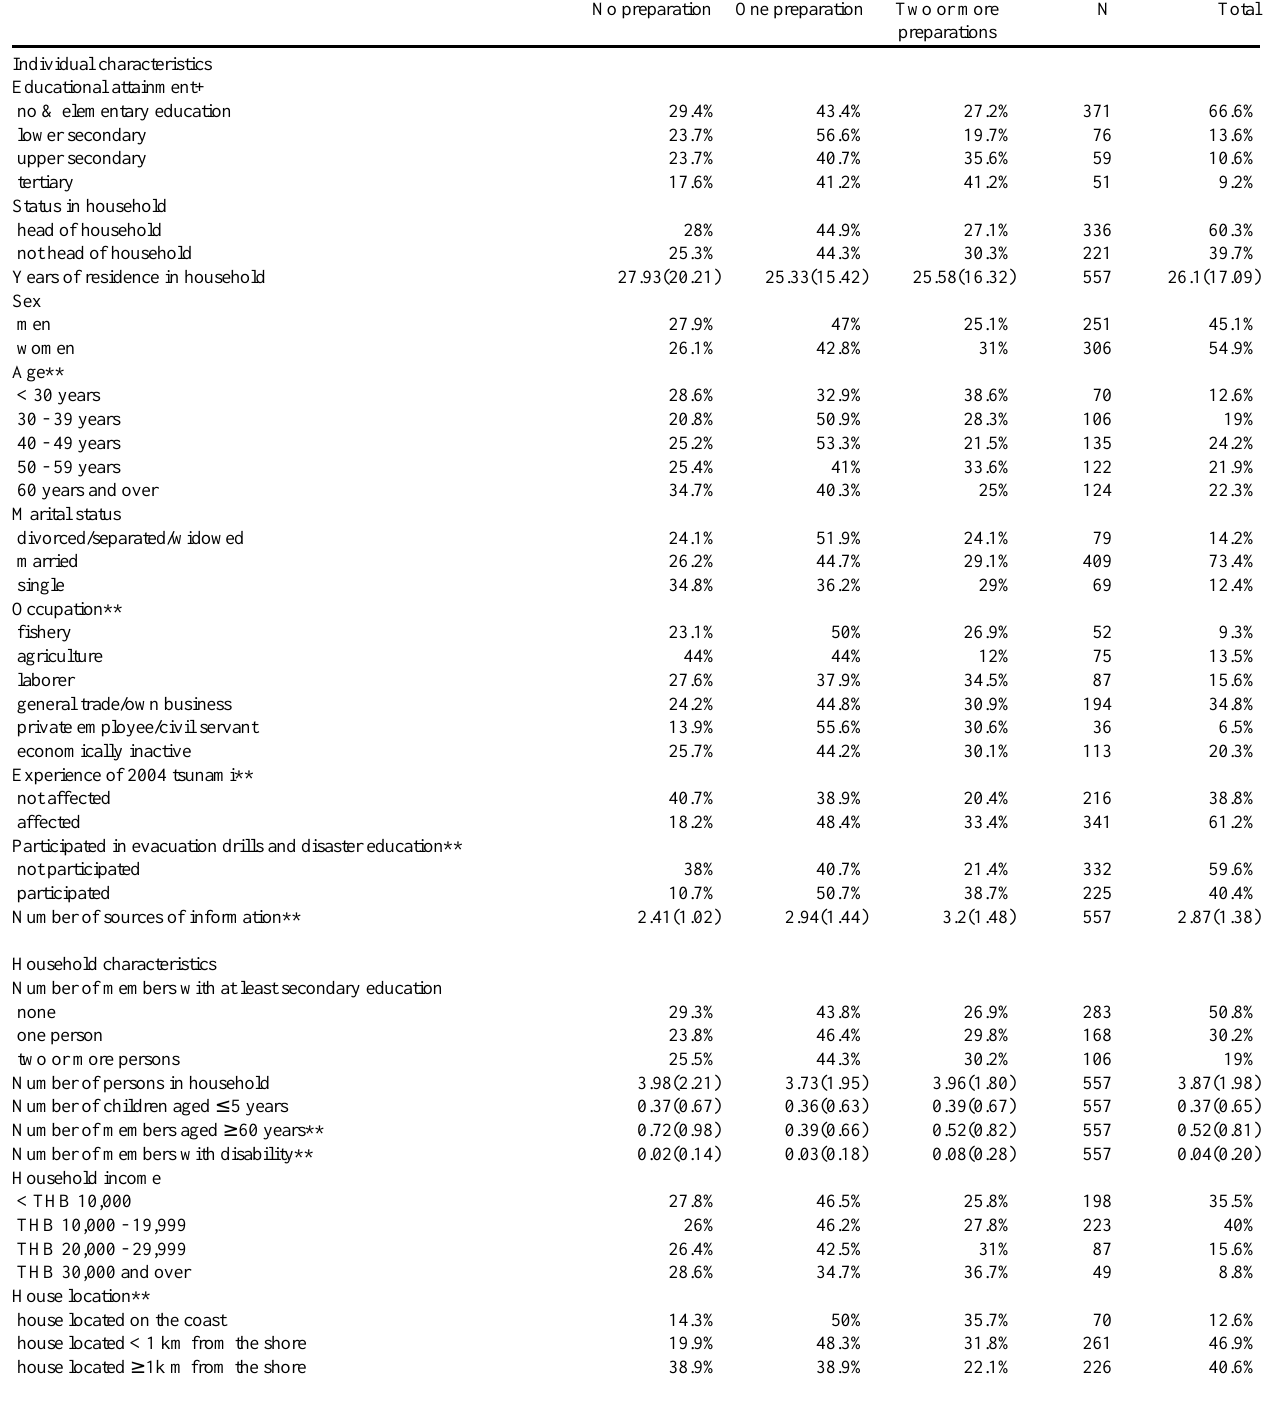
Table 1 . Summary statistics of individual-, household-, and village-level characteristics and binary relationships between these characteristics and disaster